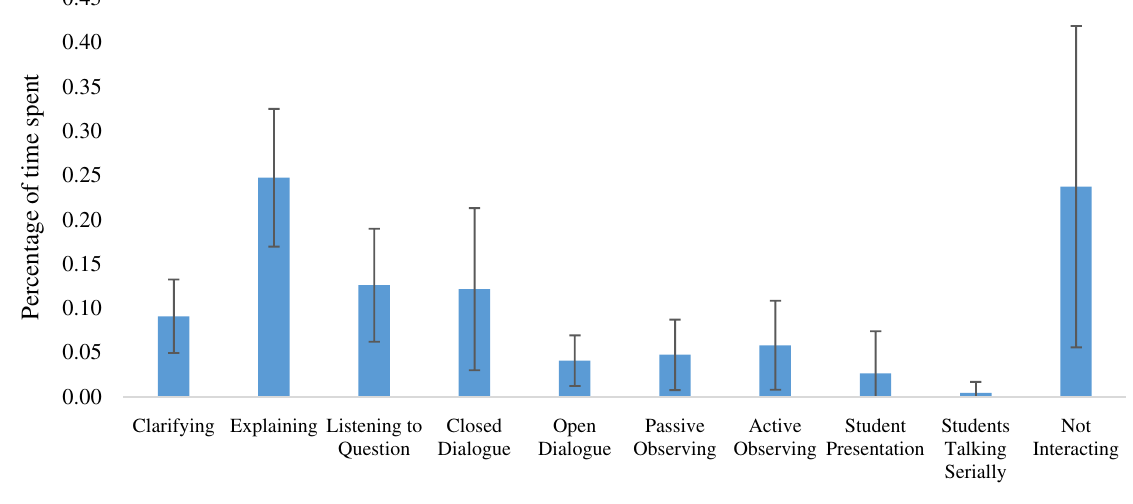
FIG. 4. Average of all TAs ’ actual profiles as coded by